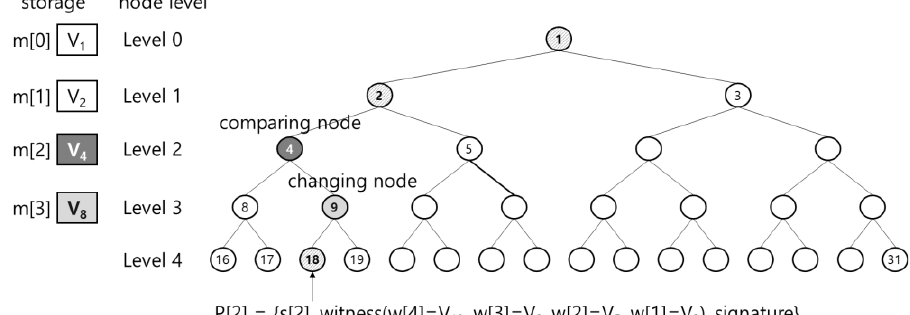
Figure 4. The segment verification process of the proposed scheme.